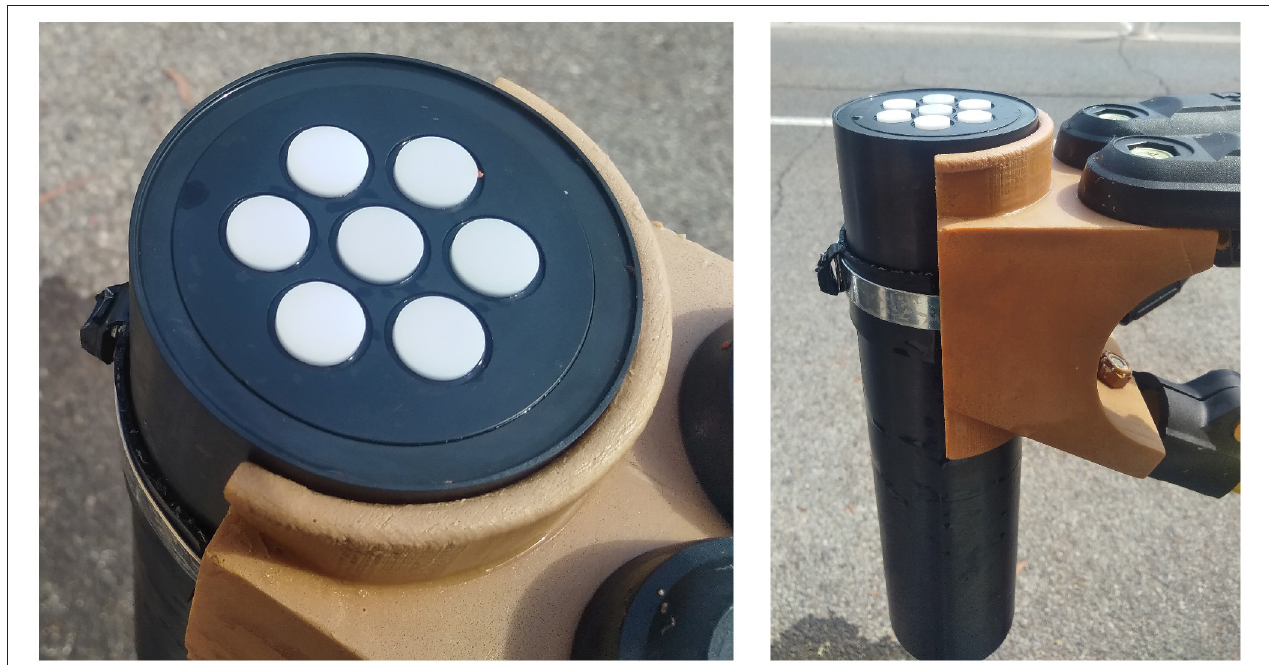
FIGURE 8 | Pictures of the sensor just after the recovery and without any cleaning after 2 months at sea in summer in the Mediterranean Sea.